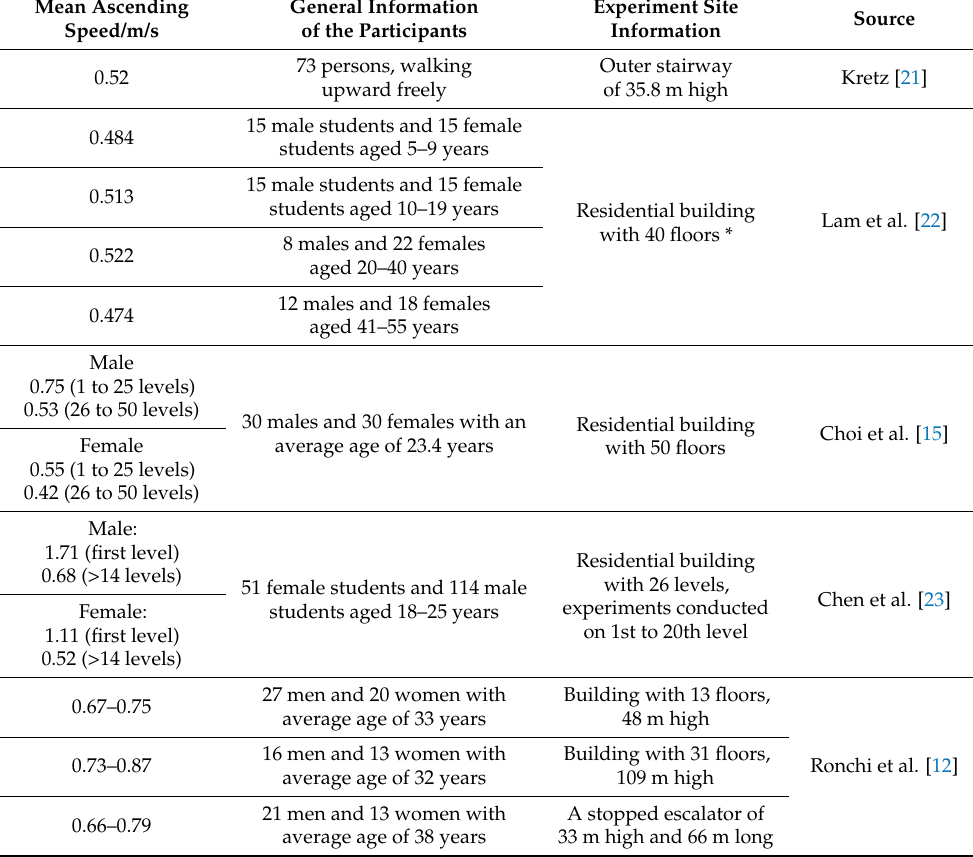
Table 1. Individual ascending speed on long stairway from the